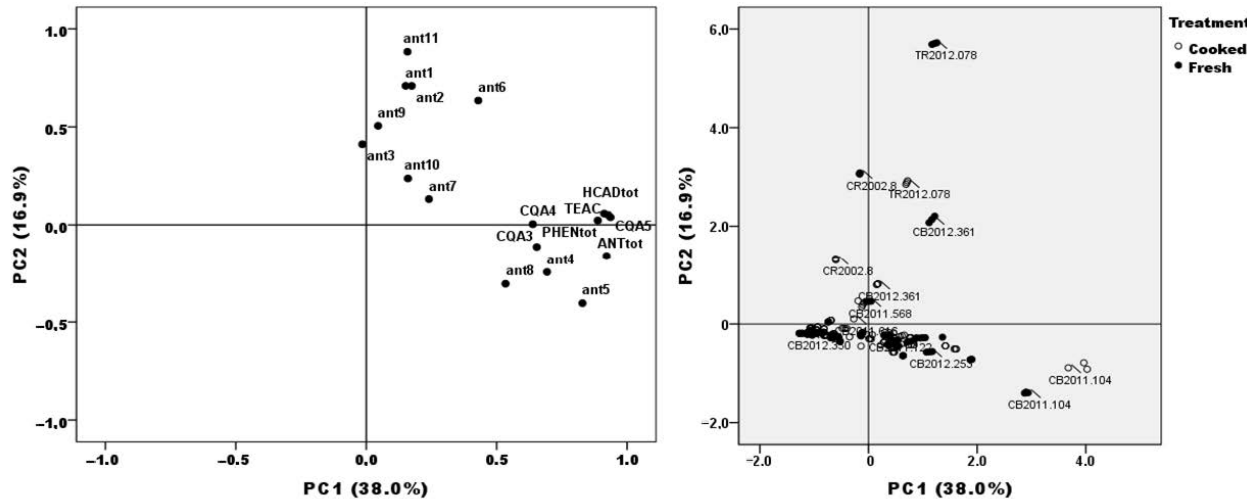
Figure 3. Principal component (PC) analysis for individual and total anthocyanin and hydroxycinnamic acid derivatives concentrations, antioxidant activity (TEAC), and total phenols (Folin–Ciocalteau) of all genotypes used in this study. Percentage values in parentheses indicate the experimental variation explained by each PC. Left : principal component analysis (PCA) distribution of the diverse experimental variables here analyzed based in its loading values. Right: Distribution of all the experimental units according to the scores regarding the two first PC extracted.